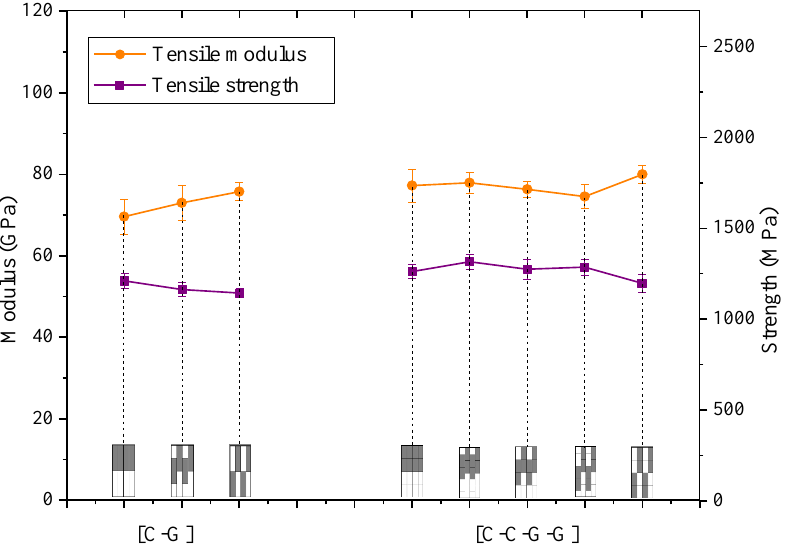
Figure 20. Comparison of tensile modulus and strength of intralayer hybrid structure with C:G = 1:1.